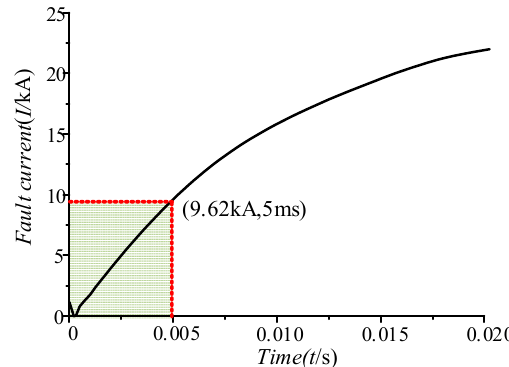
Figure 9. Fault current of DCB1 under Fault F2.